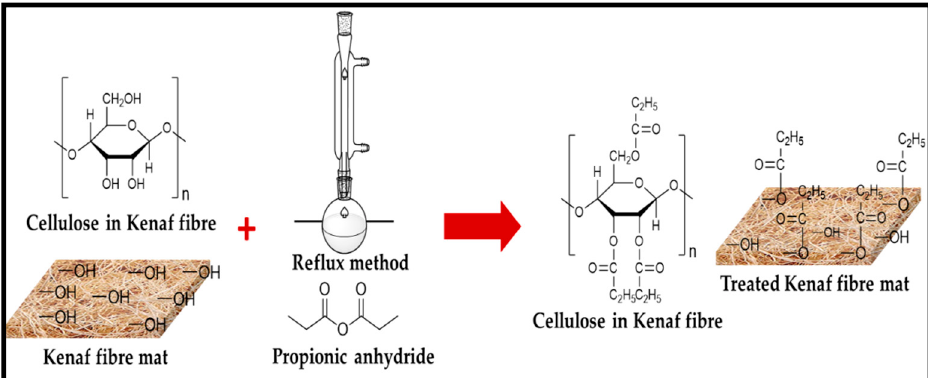
Figure 1. Schematic of chemically modified kenaf fibre.